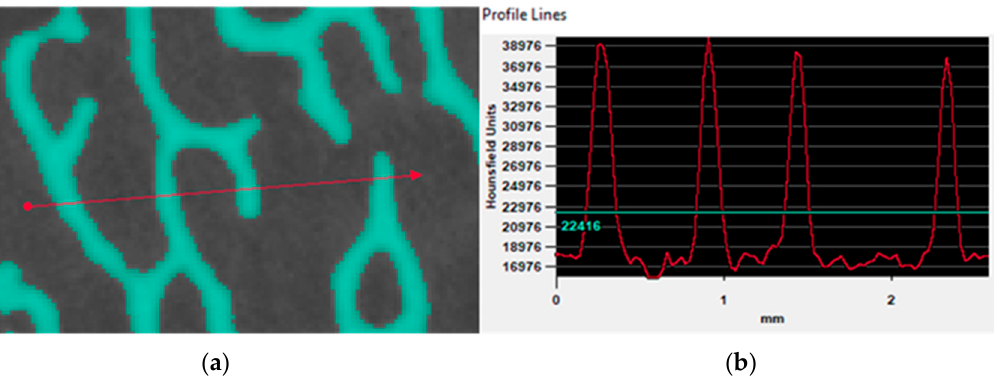
Figure 7. Gray value analysis on a micro level on the Micro CT. The arrow on the micro-CT slice image of the trabecular bone ( a ), corresponds to the HU profile displayed in ( b ). Table 4. Trabecular bone analysis in ImageJ BoneJ. The trabecular thickness and spacing of specimen CY#1 and CY#2 are analyzed using 3-matic software [11] to create a color map showing the variation of thickness and spacing. The trabecular thickness, spacing, and representative histograms of CY#1 are displayed in Figure 8. The histogram shows the number of mesh triangles with assigned color for